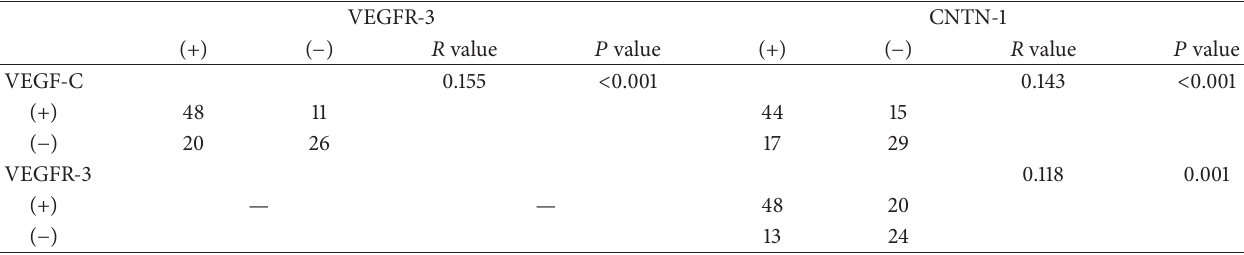
Table 2: Correlation of VEGF-C, VEGFR-3, and CNTN-1 expression ( 𝑛 ).